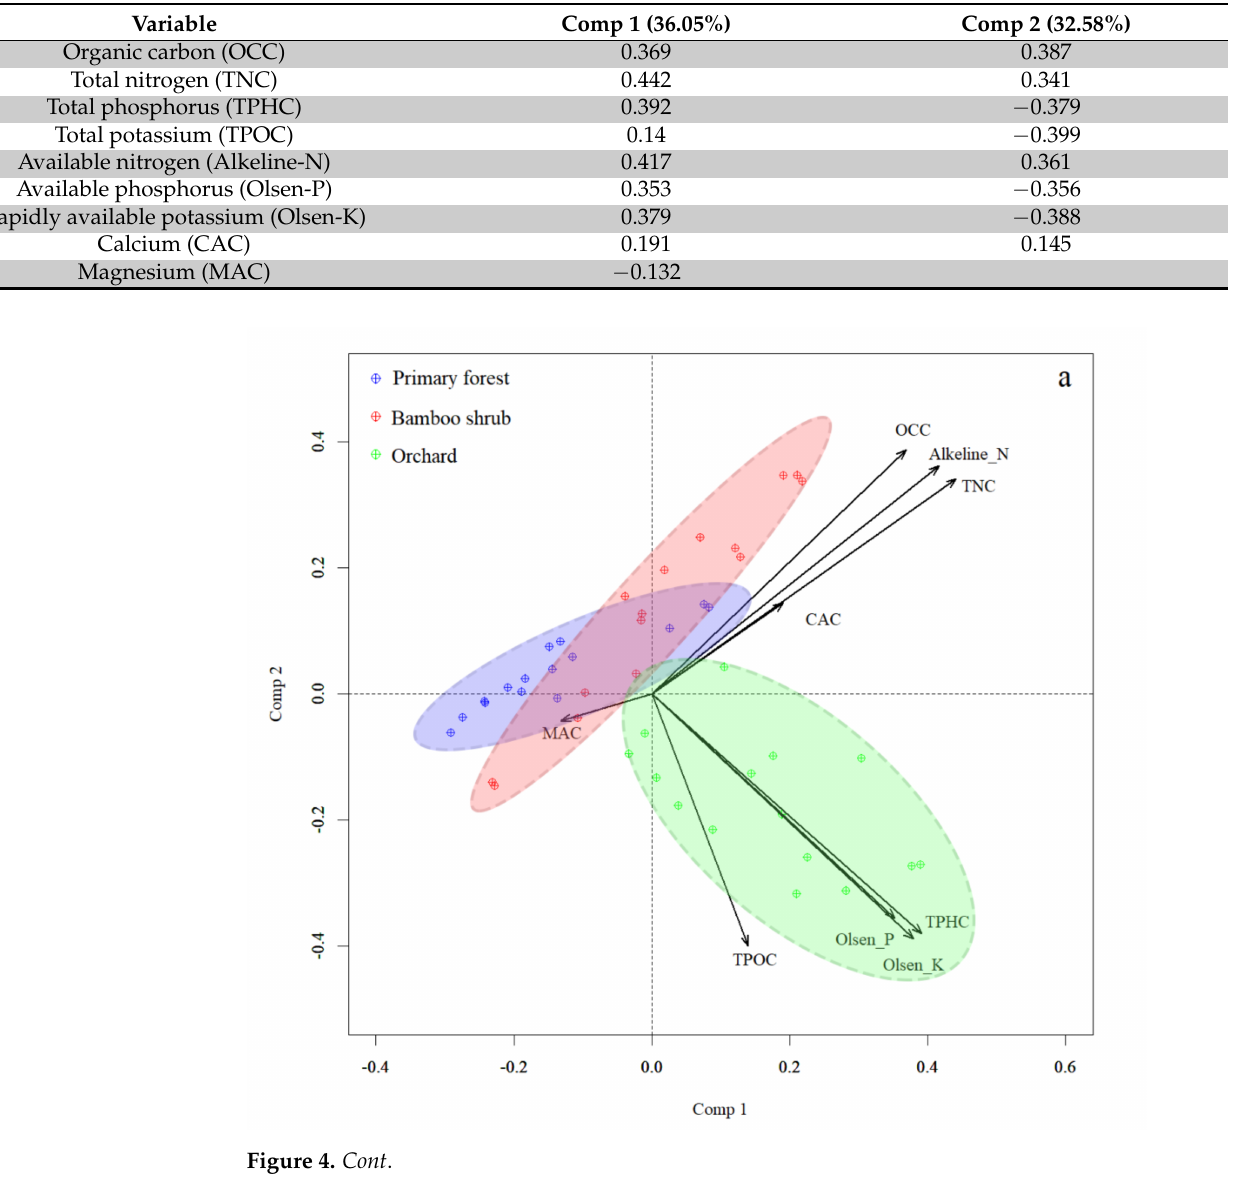
Table 2. Coefficients of the linear combinations of variables making up the principal components of nine soil